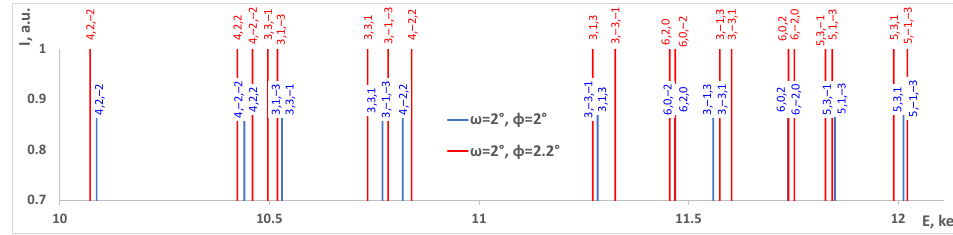
Figure 3. Simulated glitch spectra for MUL lens at ω = 2° and two ϕ angles: 2° and 2.2°.